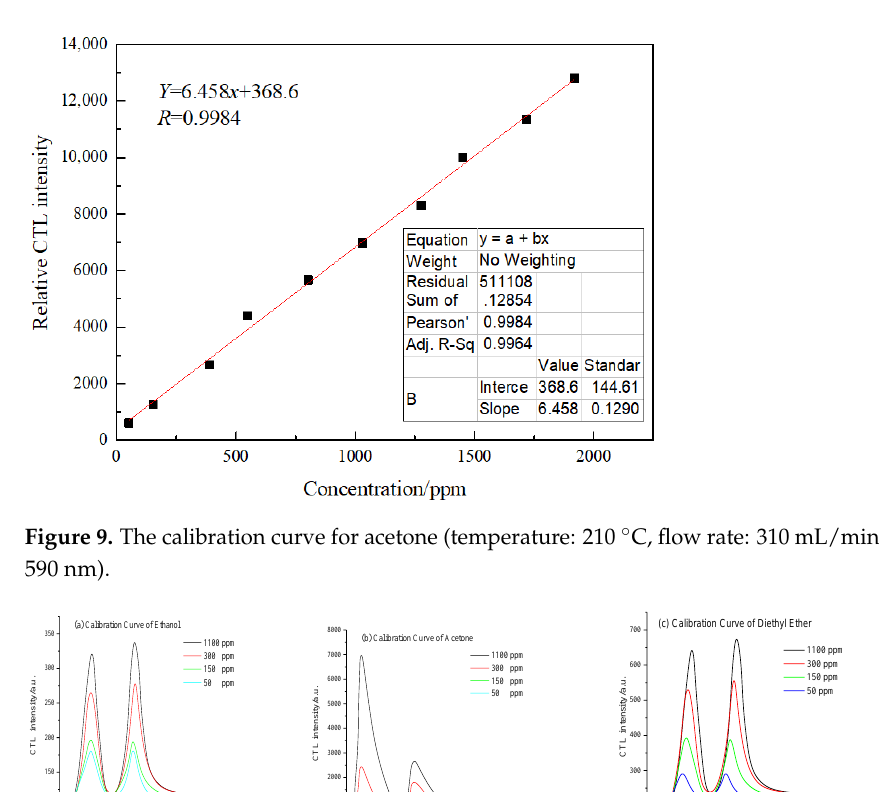
Figure 9. The calibration curve for acetone (temperature: 210 °C, flow rate: 310 mL/min, wavelength: 590 nm).